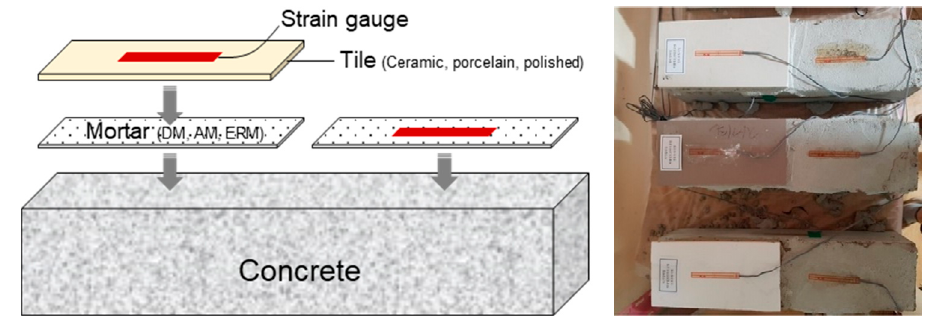
Figure 5. Test method for the shrinkage of mortar and tile.